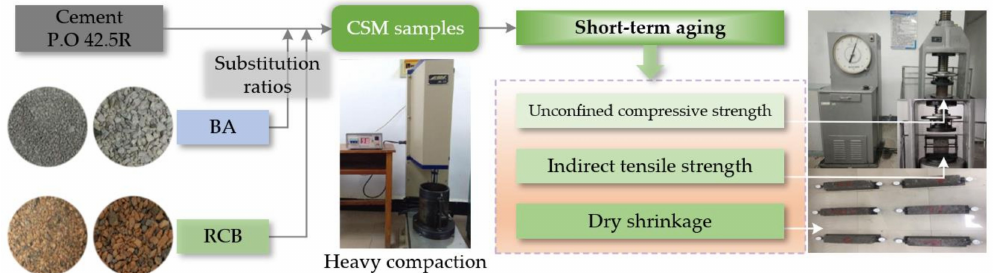
Figure 4. The flowchart of this